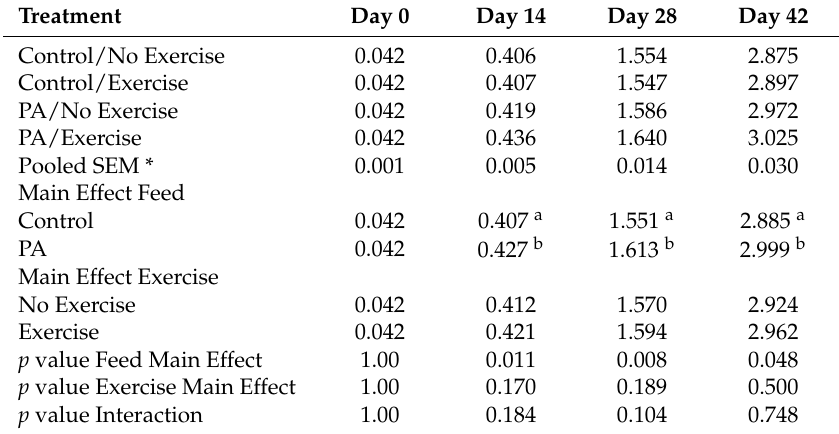
Table 3. Average live bird weights (kg) during growout in Experiment 1.